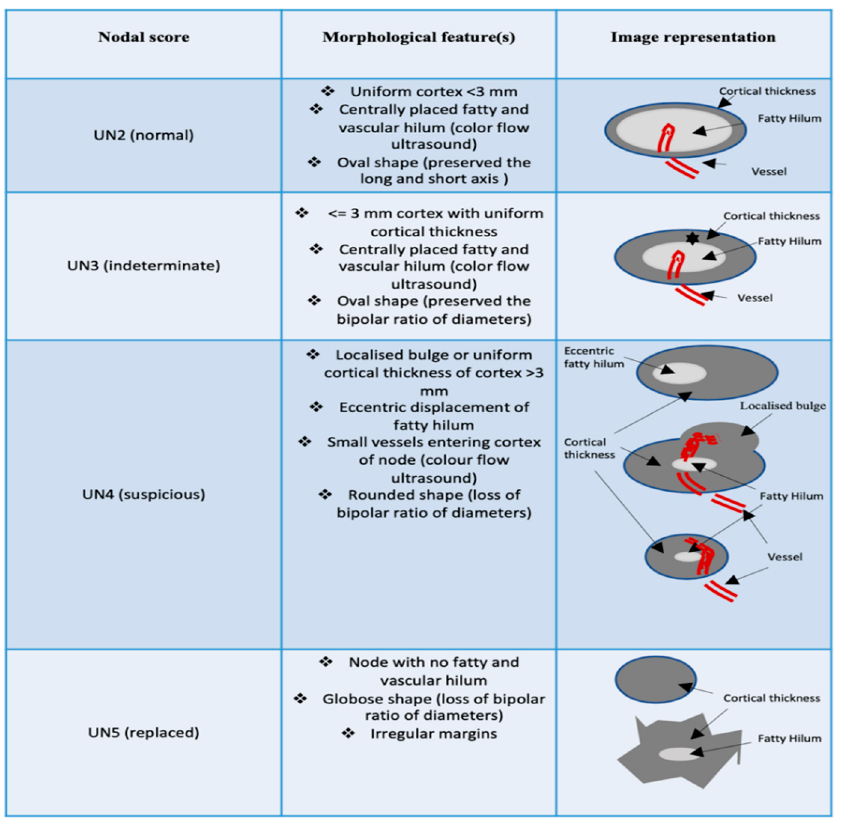
Figure 1. Allocated nodal score according to morphological and vascular features during ultrasound exam. UN 2: Uniform cortex <3 mm, centrally placed fatty and vascular hilum (color flow ultrasound), oval shape (preserved the long and short axis) (Figure 2).